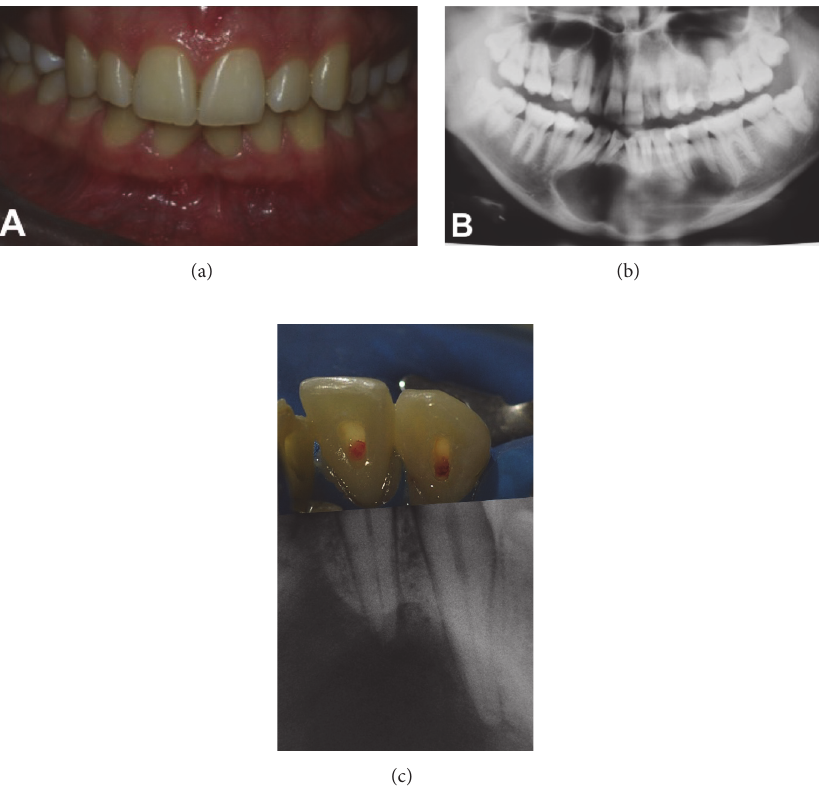
Figure 1: (a) Clinical photograph showing normal periodontal tissues; (b) initial panoramic radiograph; (c) teeth #42 and #43 with open access cavities and exposed pulp prior to instrumentation, demonstrating an error in endodontic diagnosis; relationship between clinical crowns and periapical